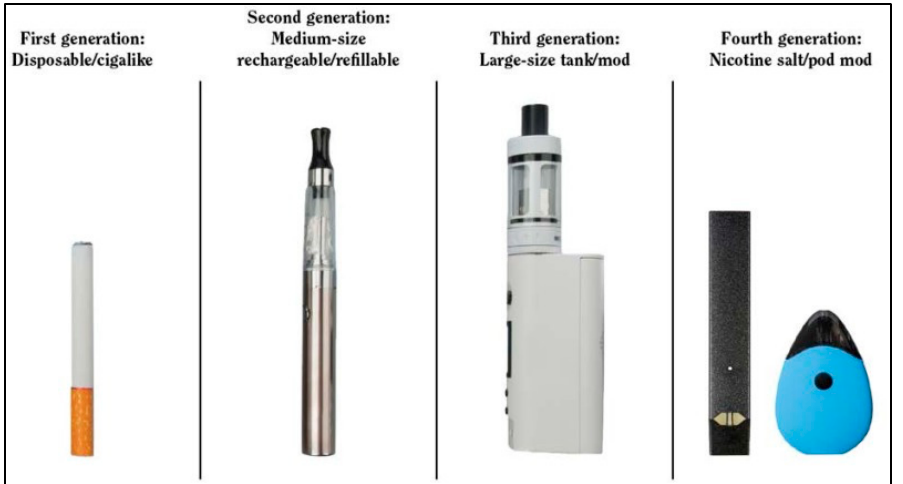
Figure 1. The evolution of e-cigarettes by product generation and characteristics (Source: Chapter 6 Interventions for smoking cessation and treatments for nicotine dependence cessation: a report of the surgeon general) [4].